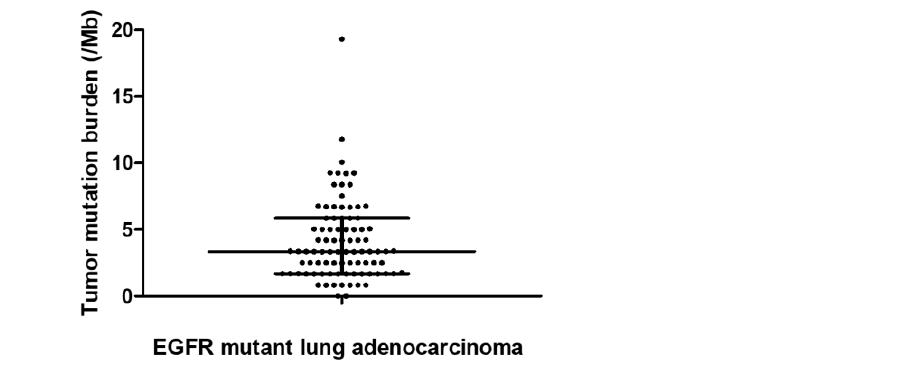
Figure 1. Distribution of TMB among the study population. Median TMB was 3.36/Mb. Bars indicate the median and interquartile range.